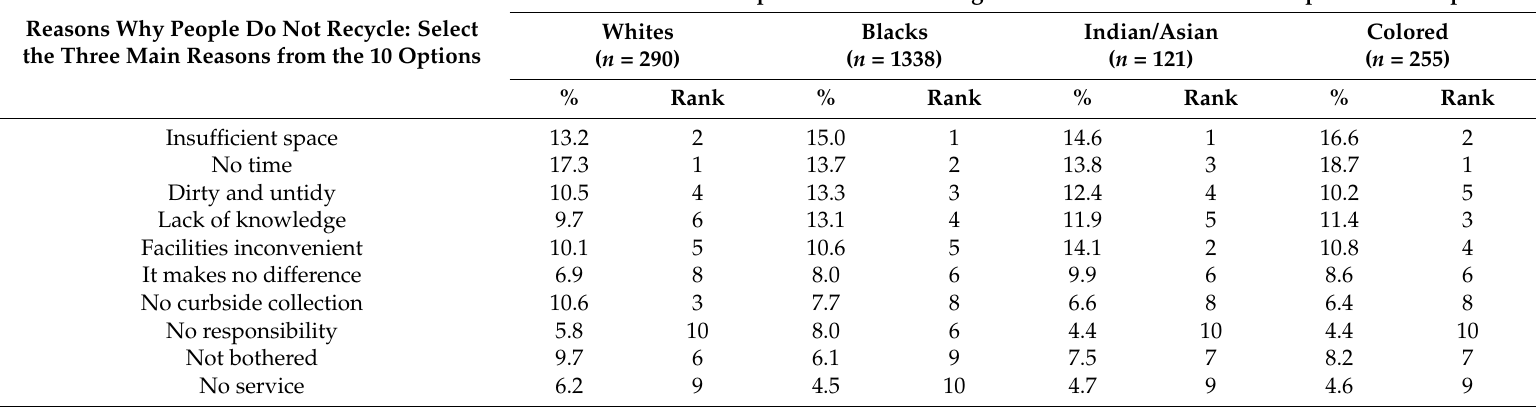
Table A8. Reasons why people do not recycle as enumerated per population/ethnic group ( n =